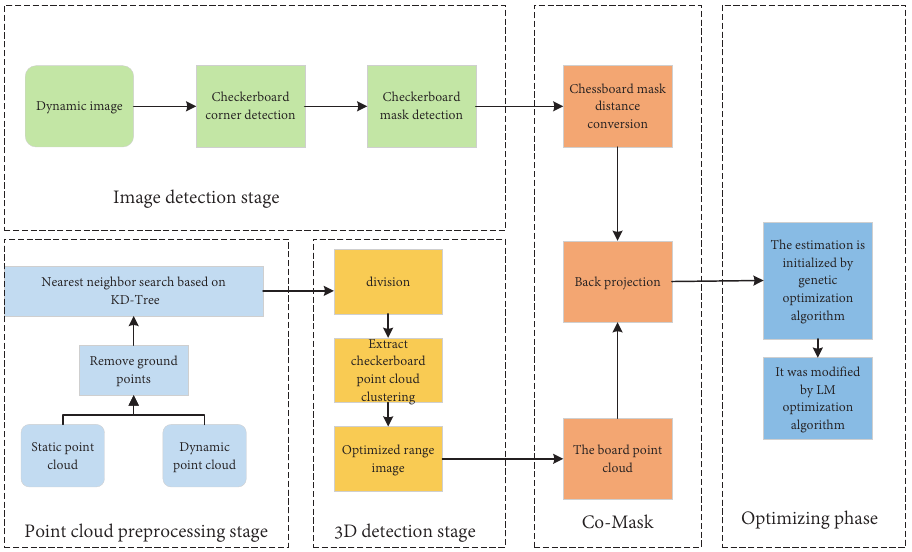
Figure 17. End-to-end frame diagram based on the 3D–2D joint correspondence mask (CoMask). Firstly, the checkerboard corner points in the image are extracted to estimate the checkerboard mask, and the Euclidean distance transformation of the mask is generated. Secondly, the static background point cloud and dynamic point cloud are removed from the ground points, the nearest neighbor search is performed, the depth-based continuous segmentation is performed on the distance image, and the clusters with an internal spatial correlation are separated. This information is sent to the back-projection process and is further processed in the optimization